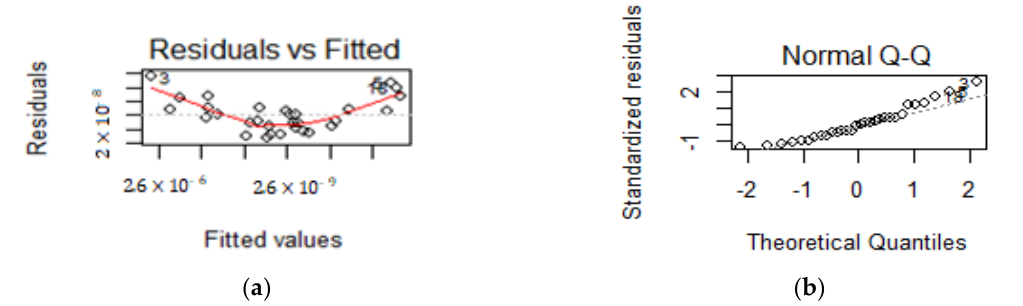
Figure 3. Matrix plot of the modeling parameters (inputs and output): case 3.2.1 — Thinner core.